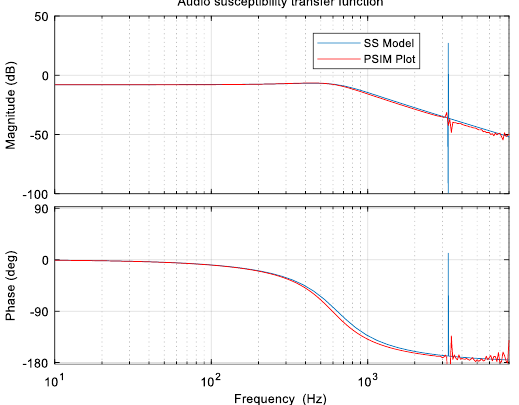
Figure 18. Control-to-output voltage transfer function for the Sepic converter.